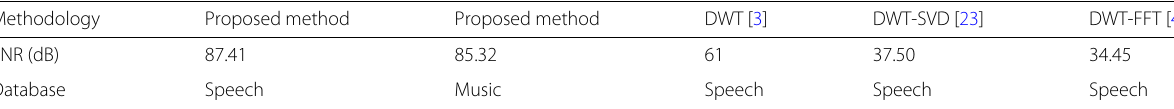
Table 1 Comparison SNR values with other techniques